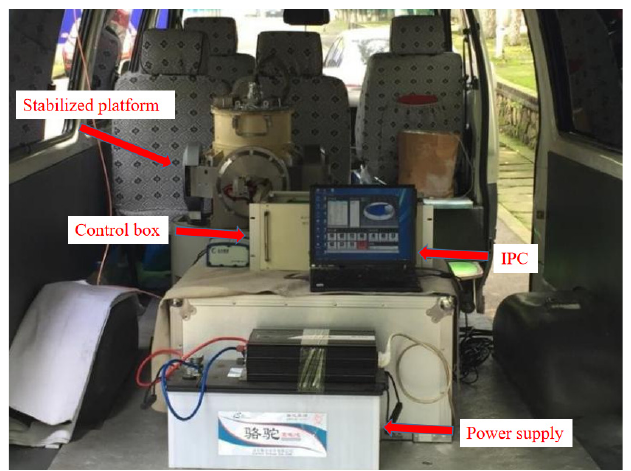
Table 5. Comparison of control effects under dynamic rolling conditions.